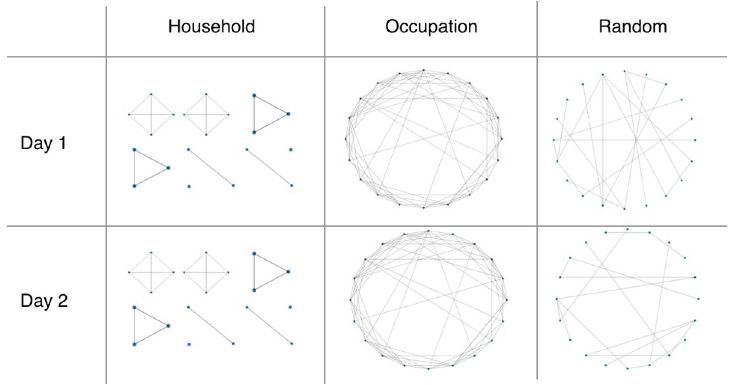
Fig 1. Schematic depiction of the interaction networks within OpenABM-Covid19. The household network is recurrent, the occupation network is a daily sample of a recurrent network, and the random network is transient and rebuilt each